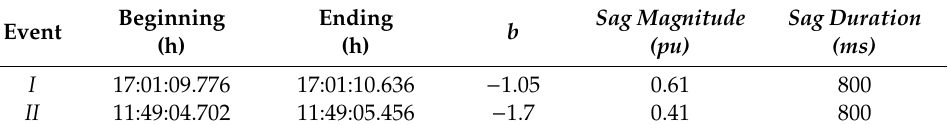
Table 3. Voltage sags characteristic summary for Events I and II .